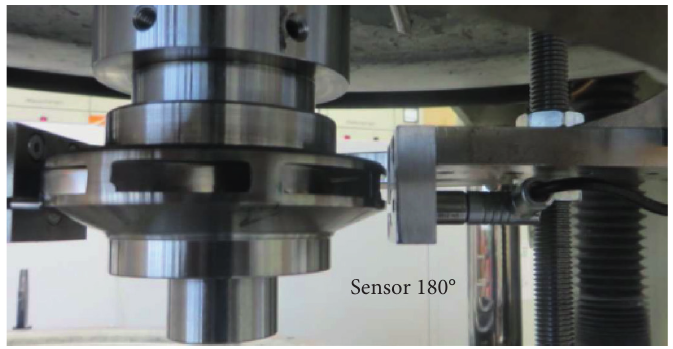
Figure 12. Sensor position for impellers C and D.